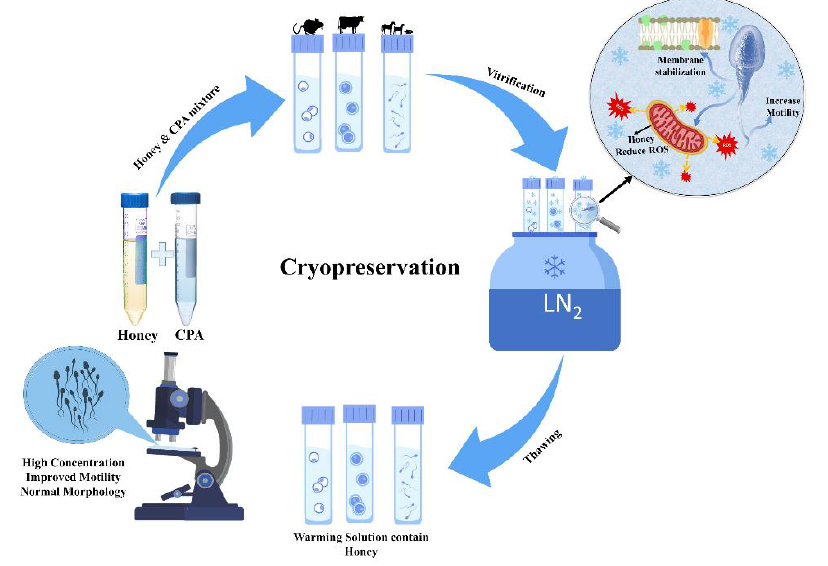
Figure 2. Cryopreservation of fertility, using non-permeating cryoprotectant honey during vitrifi-